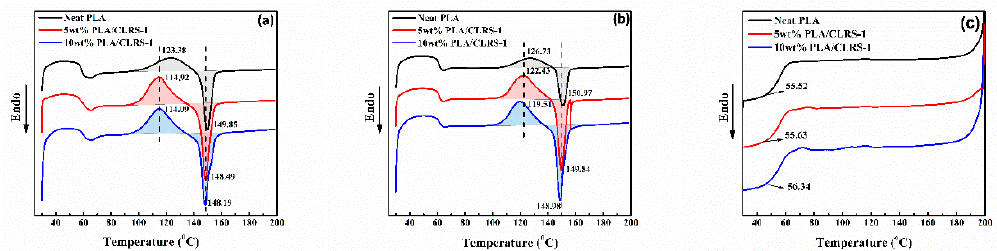
Figure 9. Differential scanning calorimetry thermogram of ( a ) the first heating, ( b ) the second heating, ( c ) the first cooling of 3D printed neat PLA and PLA/CLRS-1 composite specimens.